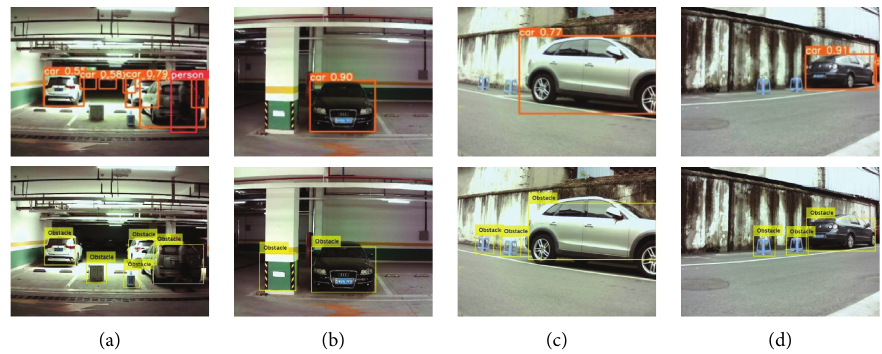
Figure 16: Obstacle detection results based on YOLO v5 and the method proposed in this paper.